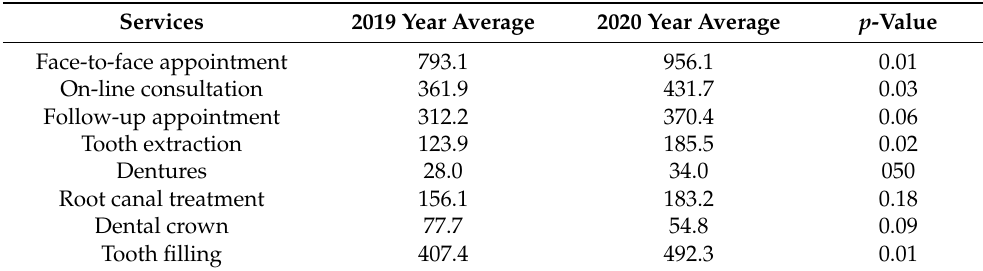
Table 1. Average of individual measured services and p -value during the pandemic period from the prepandemic period.